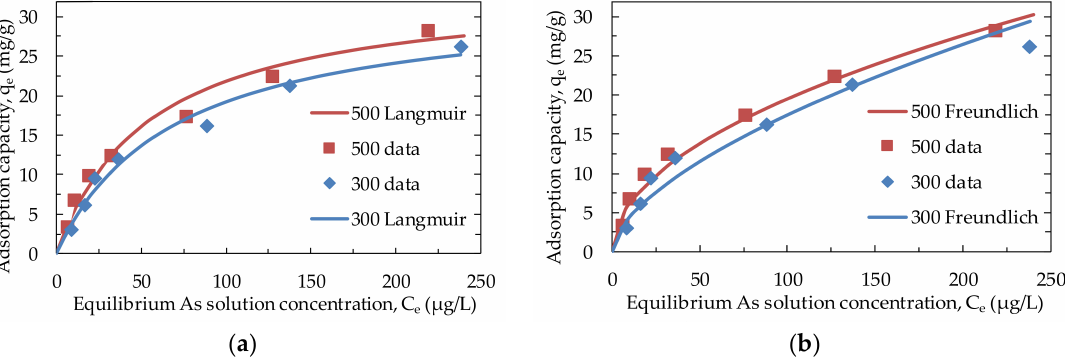
Figure 10. Arsenic adsorption isotherms with red mud obtained by alkali fusion at 300 and 500 °C: ( a ) Langmuir isotherm equation, ( b ) Freundlich isotherm equation. Table 4. Adsorption isotherms and the parameters most suitable to the data obtained.